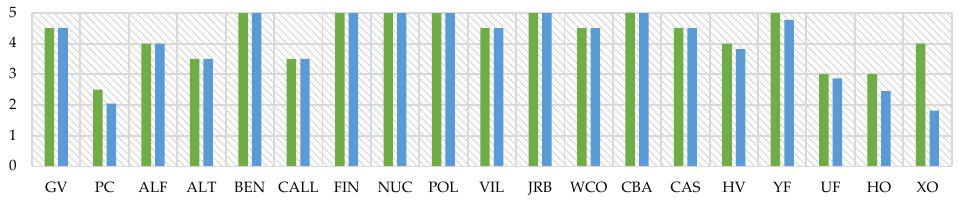
Figure 5. Interest and interest after correction factor is applied. Legend importance/influence: 0 (do not know/no answer), 1 (dispensable), 2 (unhelpful), 3 (complementary), 4 (necessary), and 5 (essential). Note: government officials (GV, PC, ALF, ALT, BEN, CALL, FIN, NUC, POL and VIL); water managers (JRB and WCO); agricultural sector (CBA, CAS, HV, YF, UF); tourism sector (HO); environmental sector